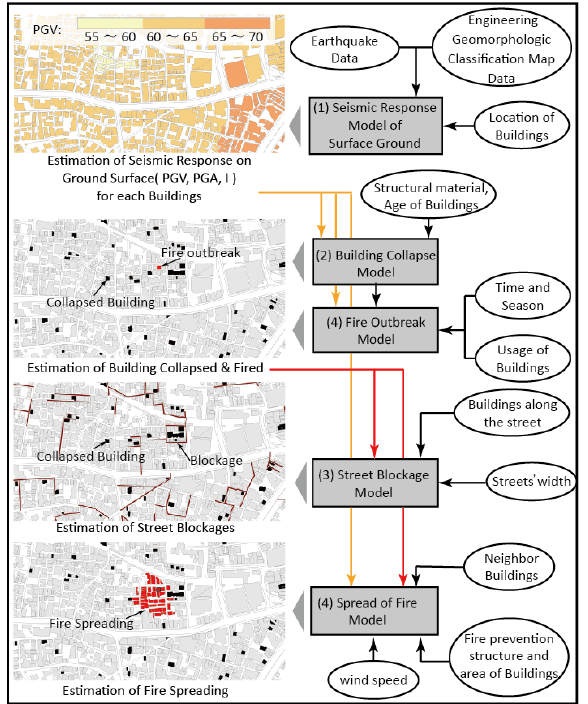
Figure 2. Outline of property damage